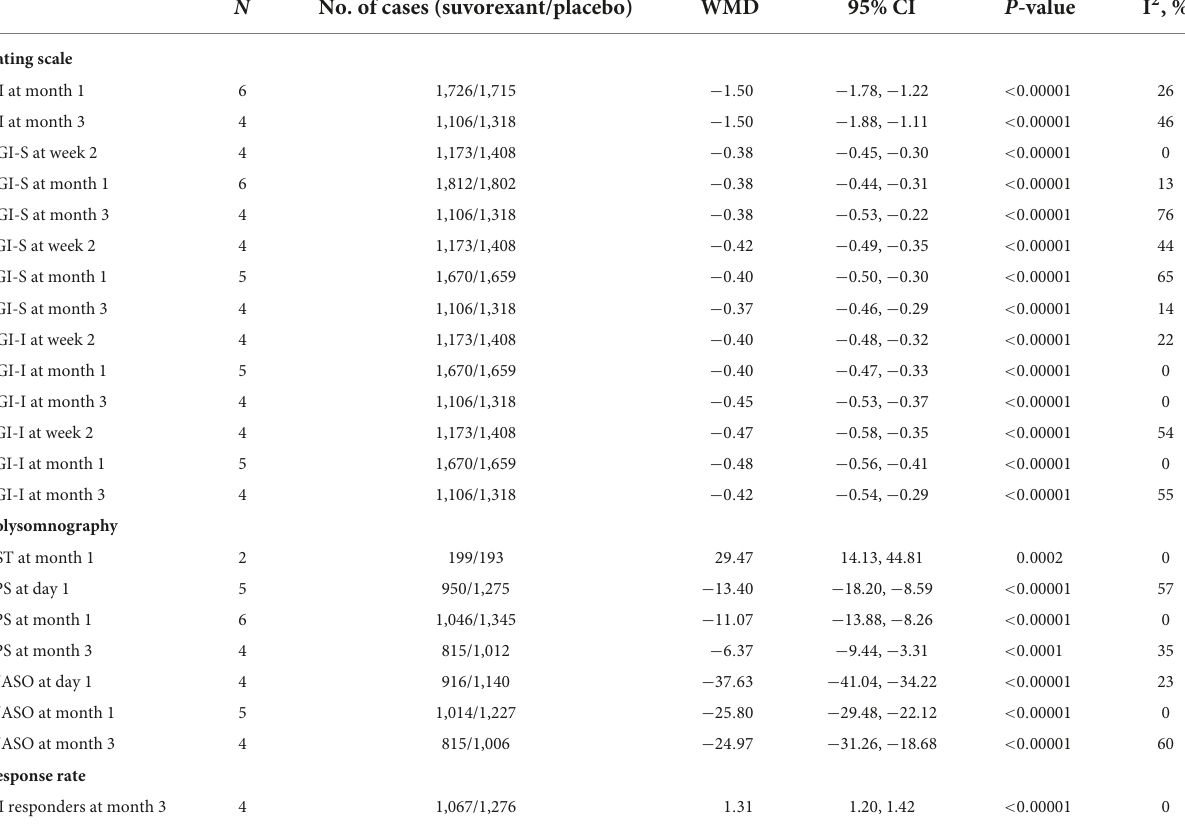
TABLE 3 Analysis of the mean changes of efficacy outcomes from rating scales and polysomnography from baseline in suvorexant vs. placebo. N No. of cases (suvorexant/placebo) WMD 95% CI P -value